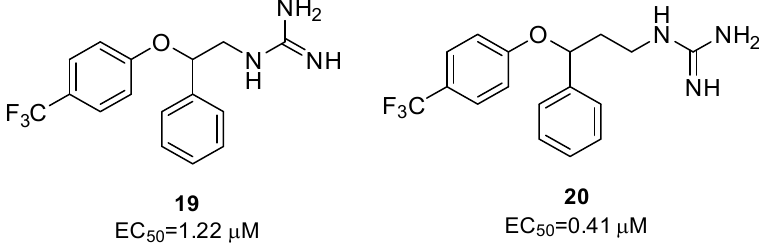
Figure 11. Chemical structures and EC 50 of compounds 19 and 20 .